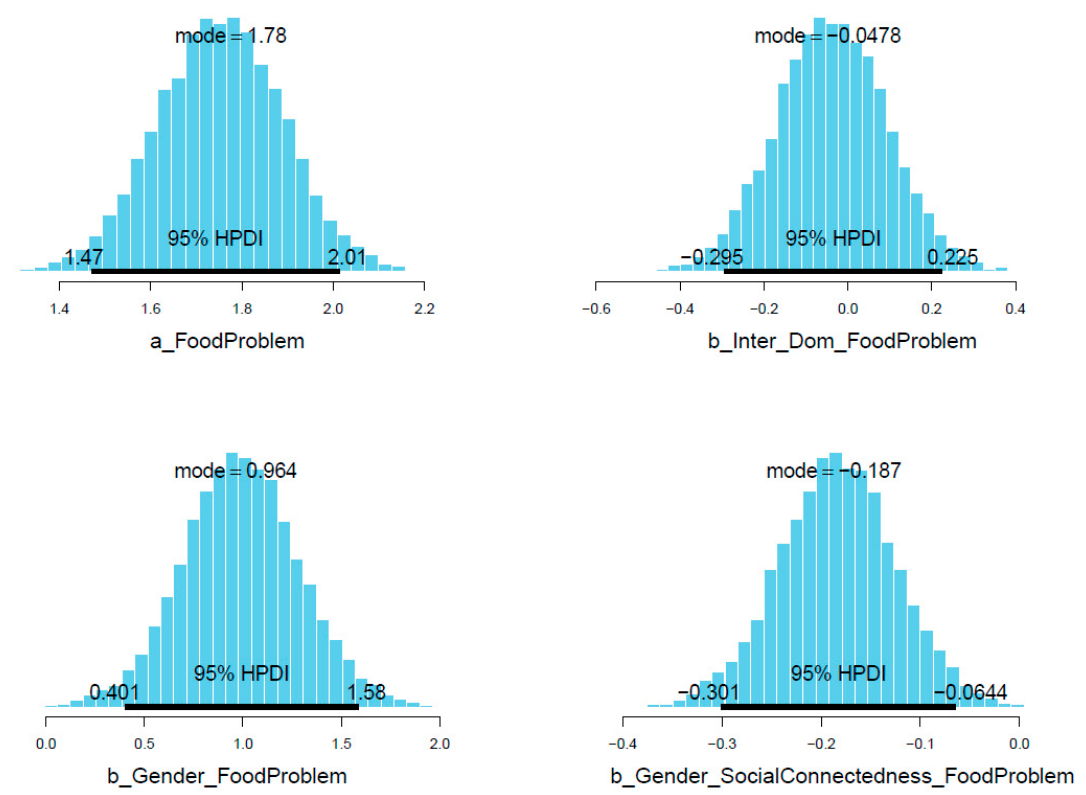
Figure 8. Distributions of the model’s coefficients with HPDI 95% .